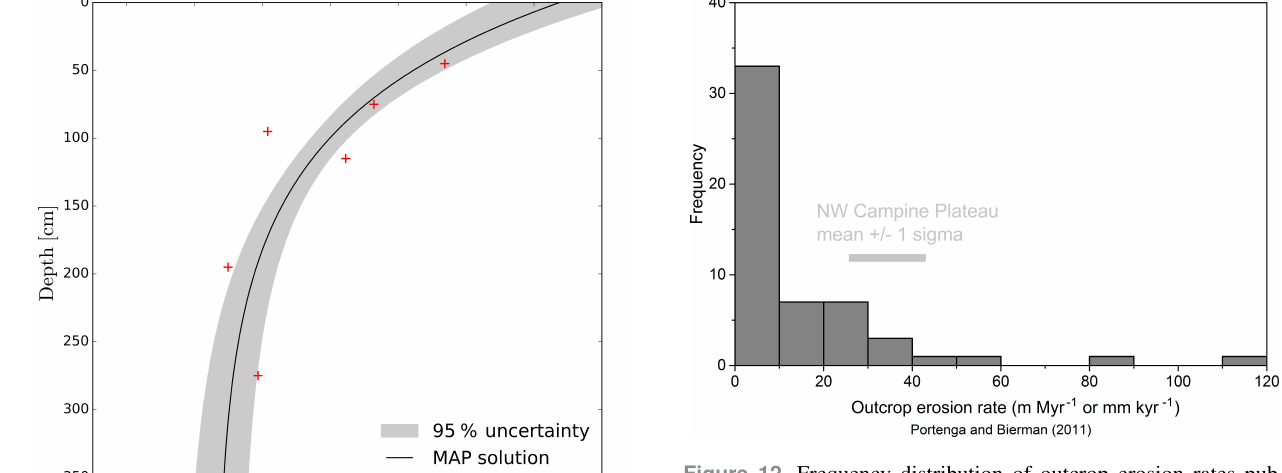
Figure 12. Frequency distribution of outcrop erosion rates pub- lished by Portenga and Bierman (2011), with indication of the mean value obtained for the northwestern Campine Plateau (this